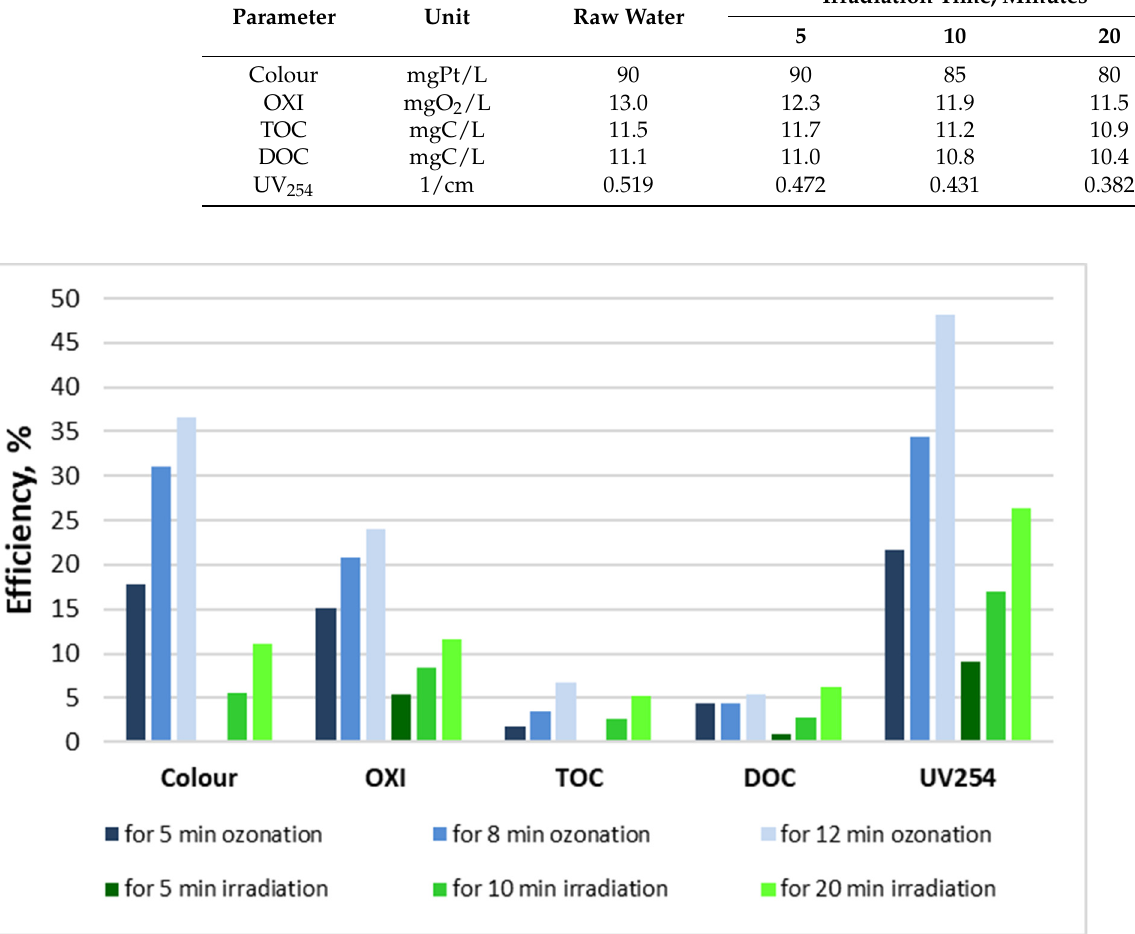
Figure 2. Efficiency of selected parameters of raw natural water removal after ozonation and UV irradiation processes.